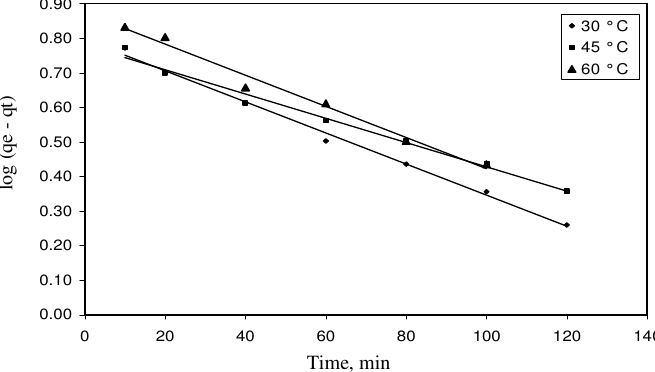
Figure 3a. Pseudo first order plot - temperature variation